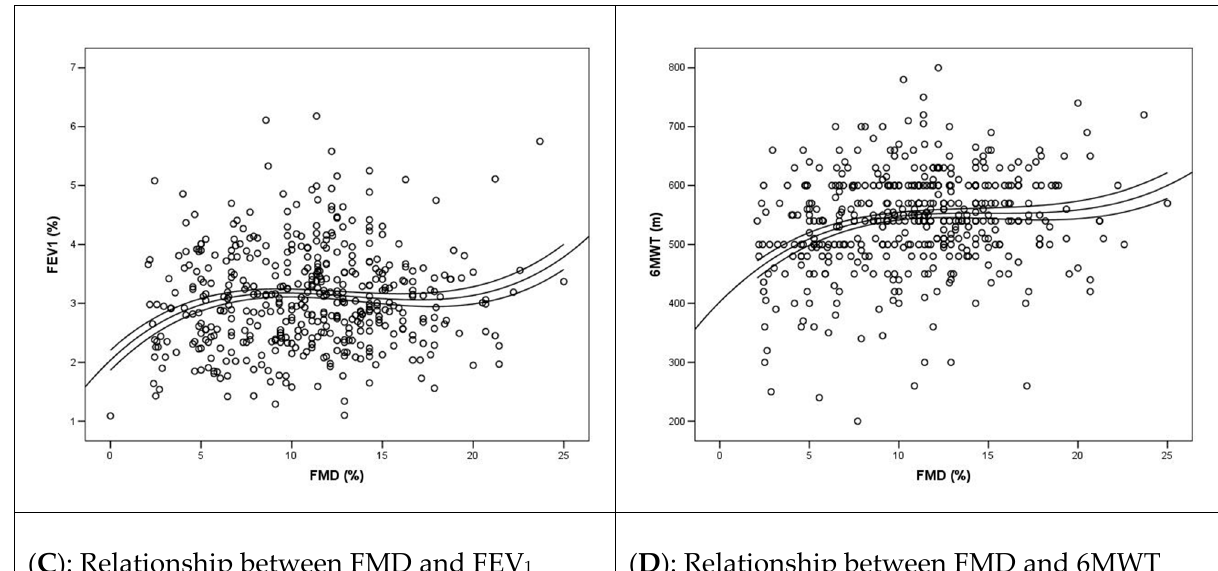
( D ): Relationship between FMD and 6MWT Figure 3. Relationship between FMD and functional outcomes in the post-COVID-19 phase.